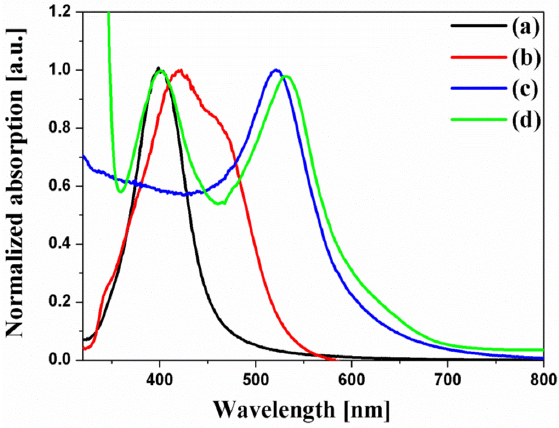
Figure 3. Normalized UV-VIS spectra of ( a ) spherical Ag NPs, ( b ) multi-shaped Ag NPs, ( c ) Au NPs, and ( d ) N719 dye. and ( d ) N719